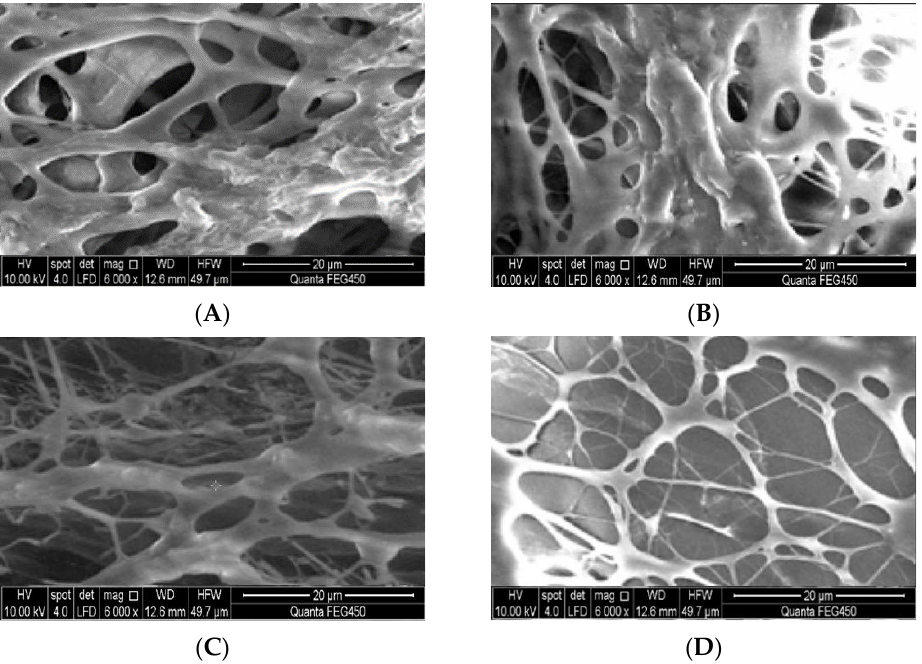
Figure 11. Gel microstructure recorded under conditions of different aging times. ( A ) Gel aging for 5 days; ( B ) Gel aging for 30 days; ( C ) Gel aging for 60 days;( D ) Gel aging for 90 days.